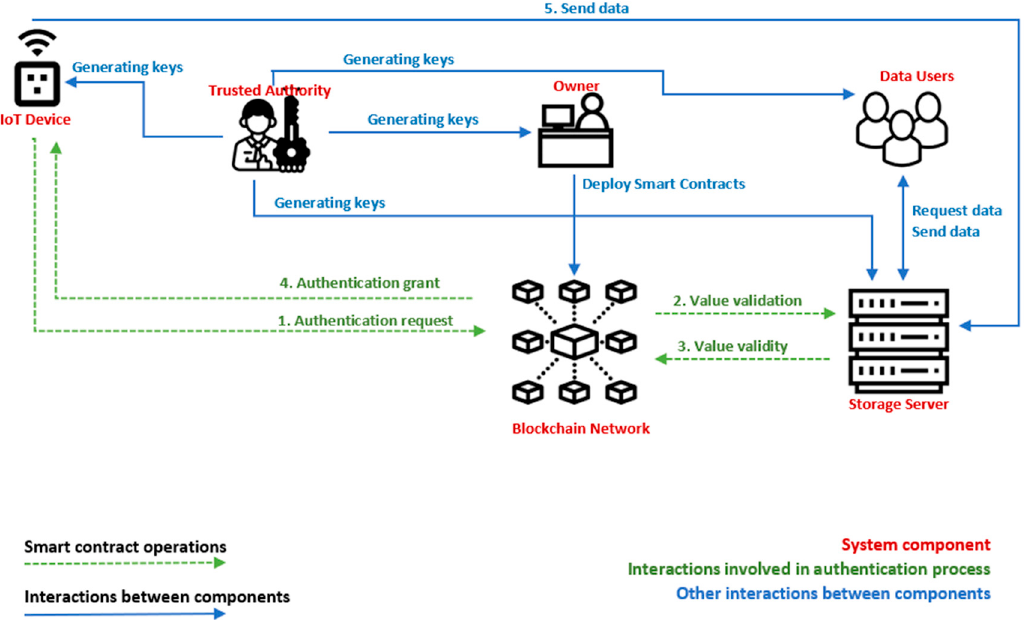
Figure 1. The architecture of the proposed system.